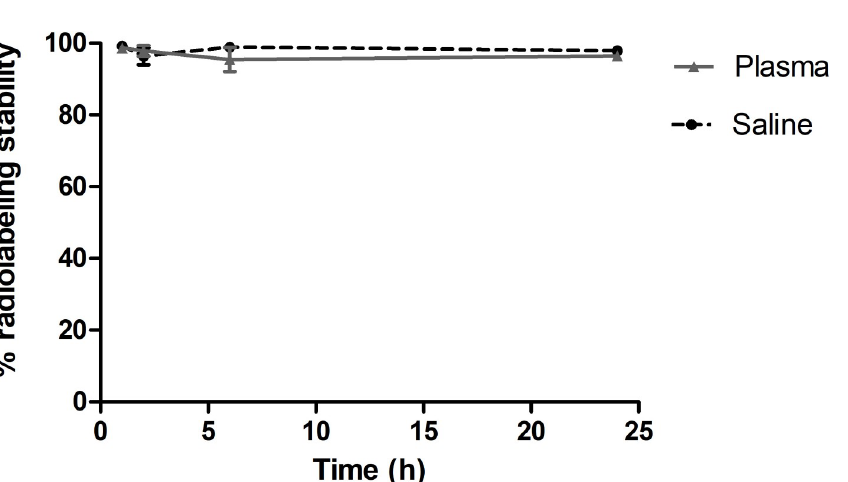
Fig 2. In vitro stability of 99m Tc-TsV. Stability of the complex 99m Tc-TsV over time in the presence of saline 0.9% (w/ v) at room temperature and in the presence of plasma at 37˚C. All values are presented as the mean ± S.E.M. of duplicates from three independent